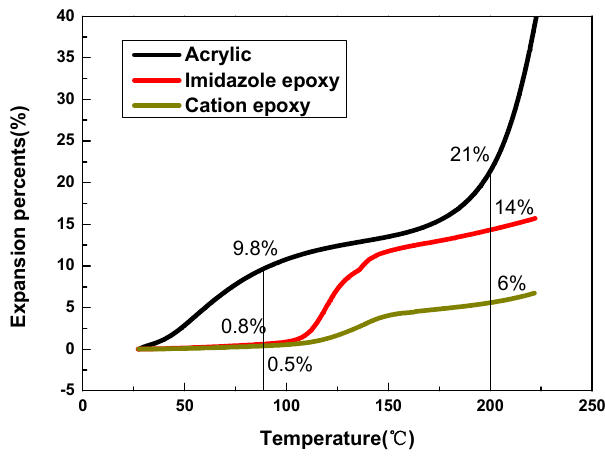
Figure 21. Thermal expansion properties of typical adhesives films.